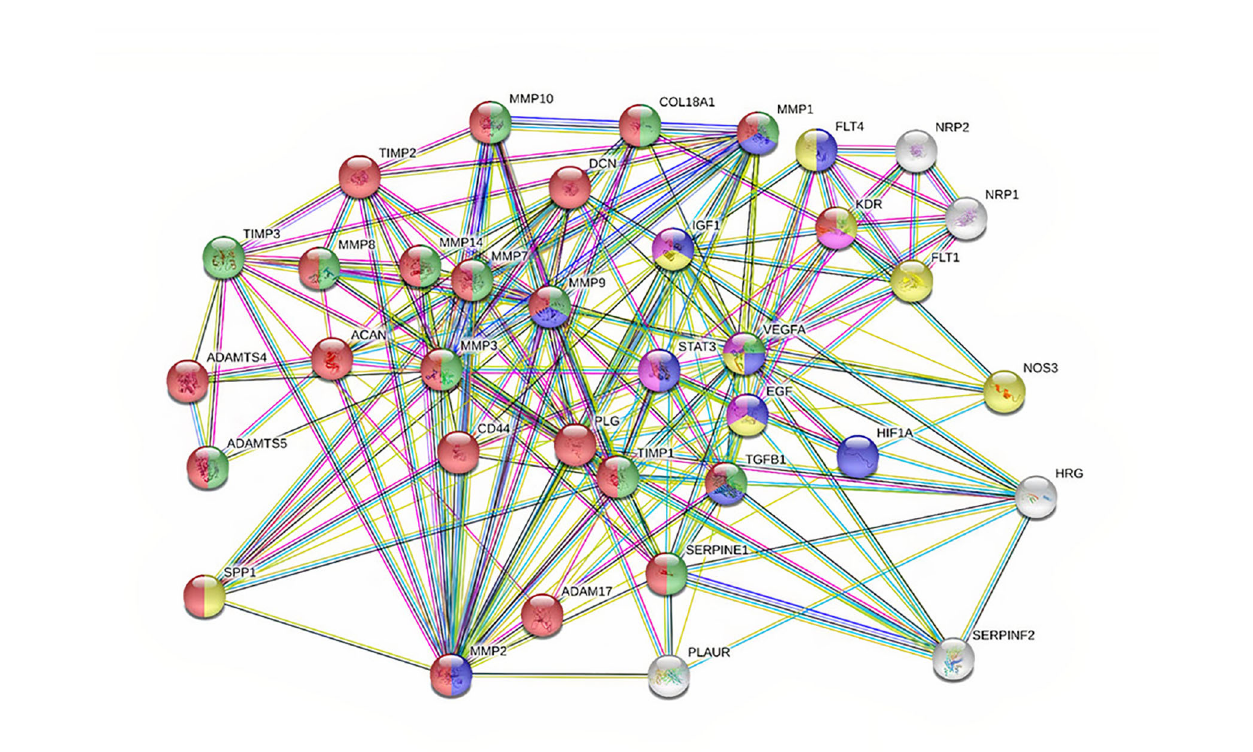
FIGURE 2 | PPI network showing 36 associated proteins in cancer. The nodes are each candidate. Edges represent their interactions. The divisions with nodes are the shared functions. Blue symbolizes those that have a function in cell proliferation. Green and Red are the ones regulating ECM. Yellow are those with proliferation and